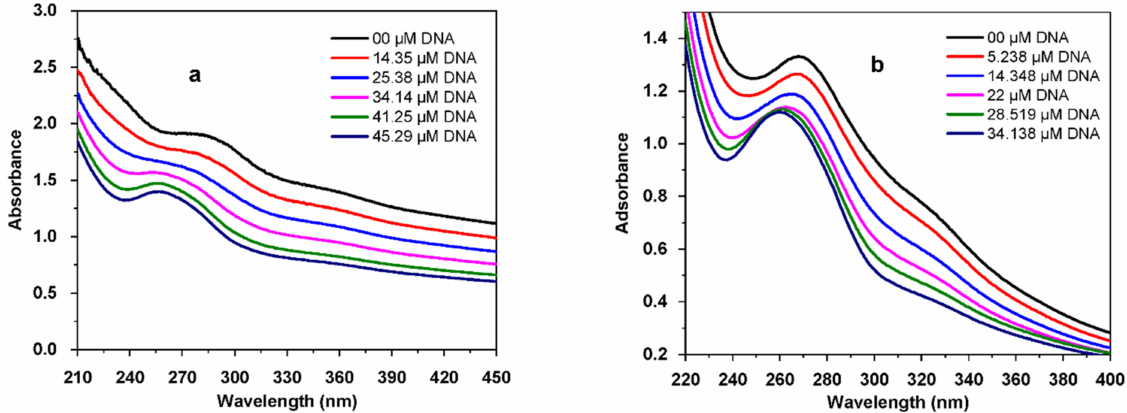
Figure 10. UV-visible absorption spectra of polysaccharidic extracts in the presence of increasing concentrations of DNA in 0.1 M phosphate-buffered solution (KH 2 PO 4 /K 2 HPO 4 ) at pH = 7.2 and 298 K: ( a ) 2 mg of E 2 ; ( b ) 6 mg of E 3